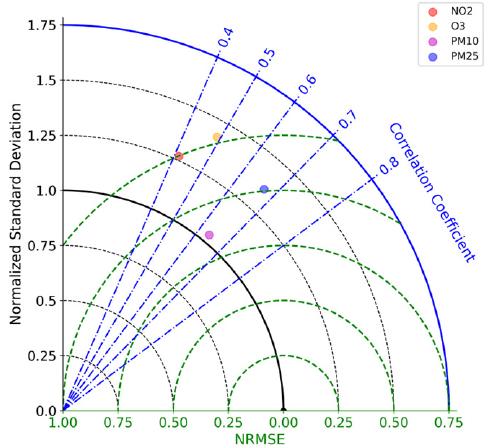
Figure 5. Taylor diagram on the right shows the statistical comparison between observed and model simulated values for Nanjing from 1 January to 29 February 2020. In terms of PM 2.5 , the WRF-Chem model could reproduce well the trend of near- ground PM 2.5 concentrations over time (R 2019 = 0.70, R 2020 = 0.67), but during the COVID-19 lockdown period, the model simulated signi fi cantly higher PM 2.5 concentrations (NMB 2019 = 32%, NMB 2020 = 45%). For PM 10 , the model was not only able to simulate the trend of